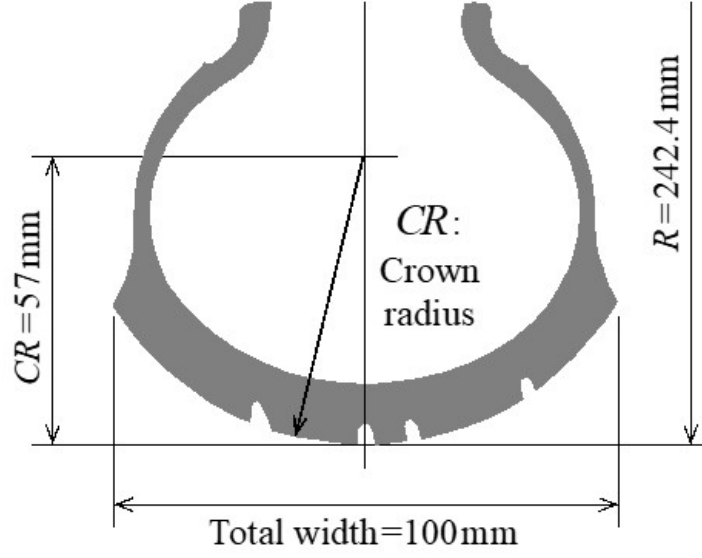
Figure 2. Typical tire cross section (Motorcycle, PMV)